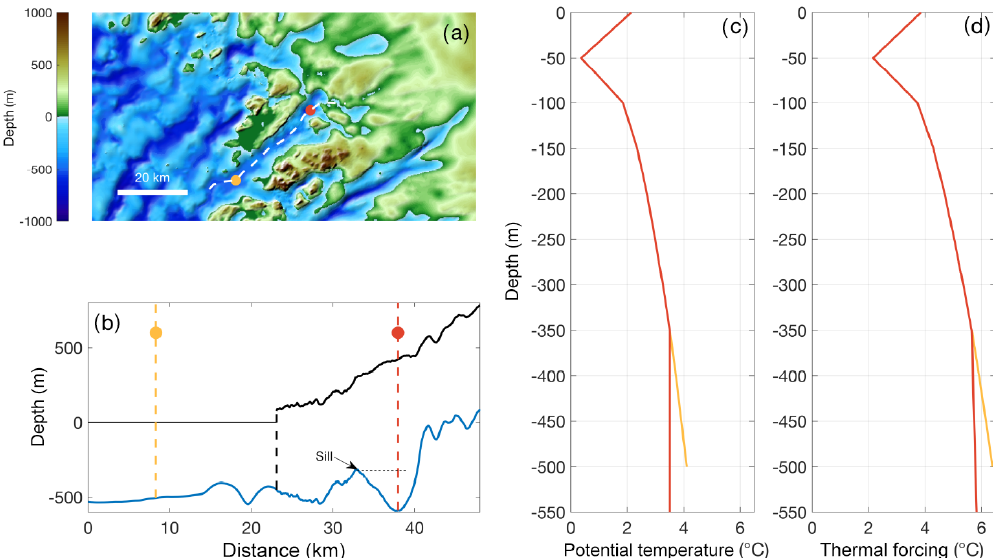
Figure 5. Illustration of ocean property extrapolation for Sverdrup Glacier and fjord, NW Greenland. (a) Overview of regional topography. The dashed white line shows an along-fjord transect, the yellow point is in the fjord and the red point is below the present-day ice sheet. (b) Bathymetry and subglacial topography (blue) and current ice sheet elevation (black) along the flow line shown as the dashed white line in (a) . The dashed yellow and dashed red lines correspond to the locations in (a) . (c) Potential temperature profiles and (d) thermal forcing profiles at the locations shown in yellow and red in (a) and (b)